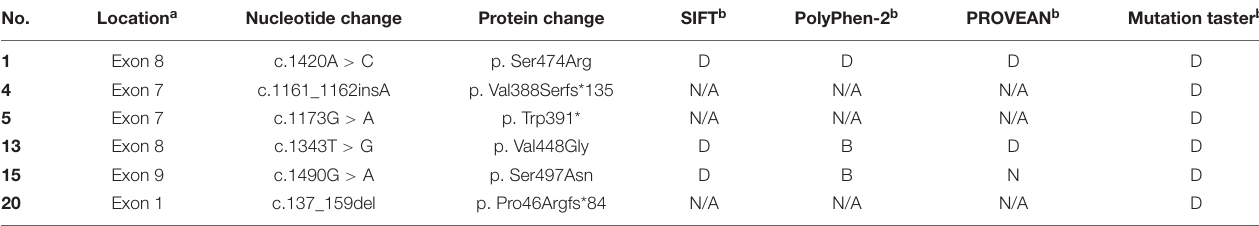
a Black bold in the table indicates novel variants identified in this study. TABLE 4 | Analysis and in silico prediction of the novel SLC22A5 gene